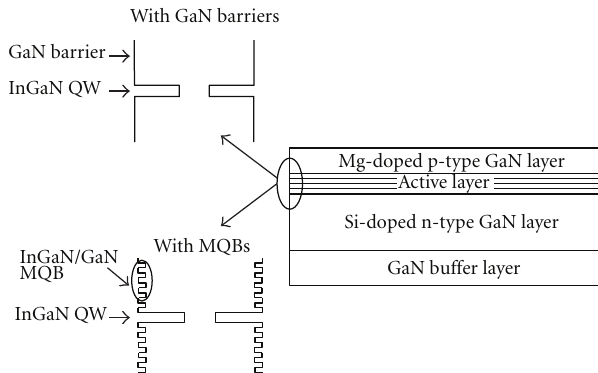
Figure 1: Schematic structure of InGaN/GaN multiple quantum well light-emitting devices (a) with GaN barrier and (b) with mul- tiquantum